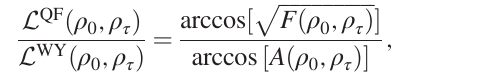
ffiffiffiffiffiffiffiffiffiffiffiffi p 1 − r 2